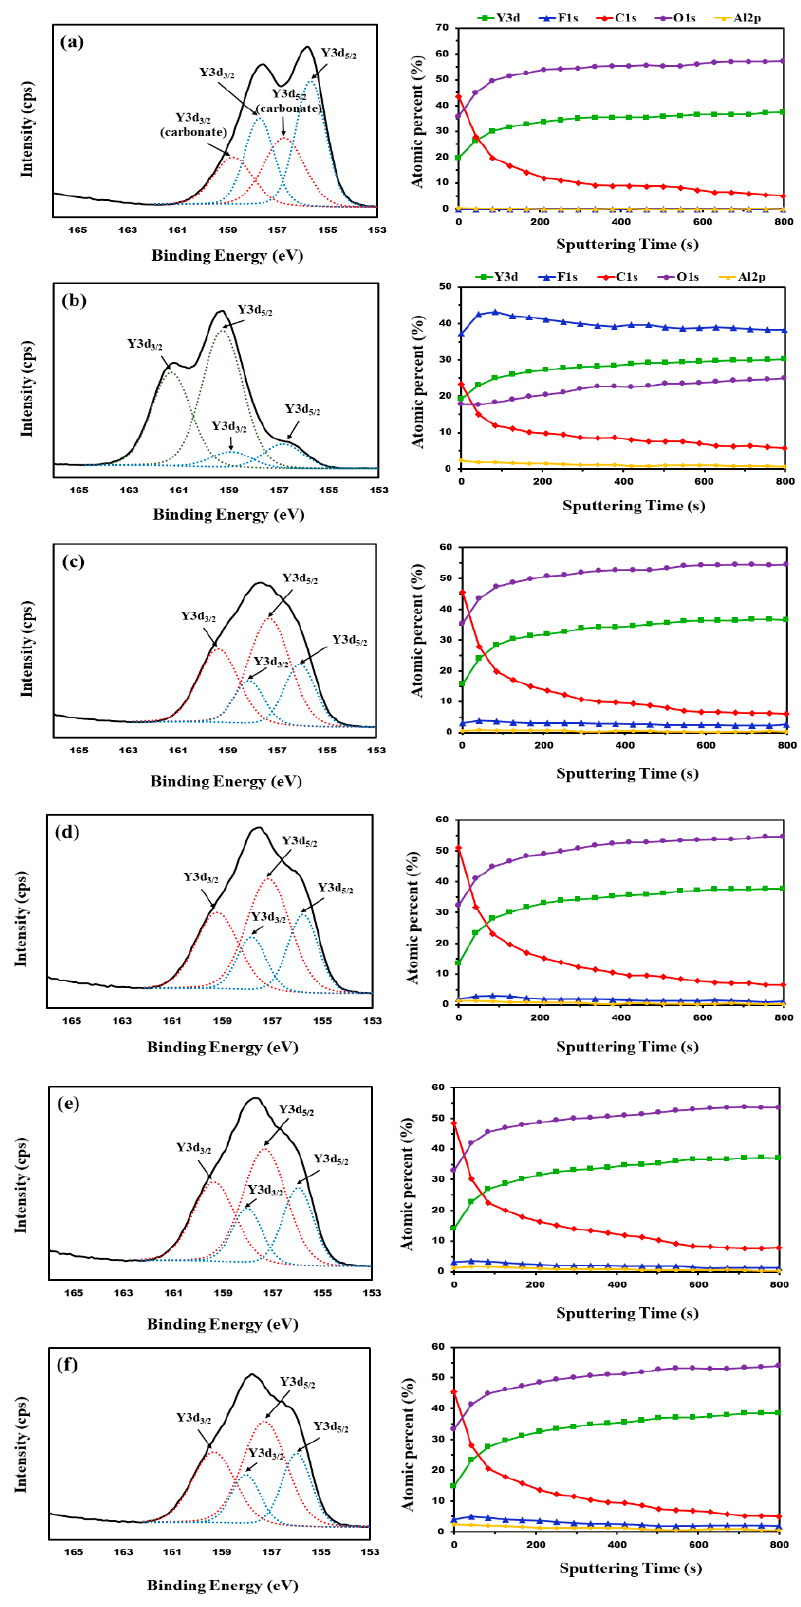
Figure 7. XPS spectrum of the surface of APS–Y 2 O 3 coatings and Ar ion sputtering depth profile: ( a ) pristine APS–Y 2 O 3 , ( b ) APS–Y 2 O 3 plasma exposure and after cleaning with piranha solutions prepared at ratios of ( c ) 2:1, ( d ) 3:1, ( e ) 4:1, and ( f ) 5:1.